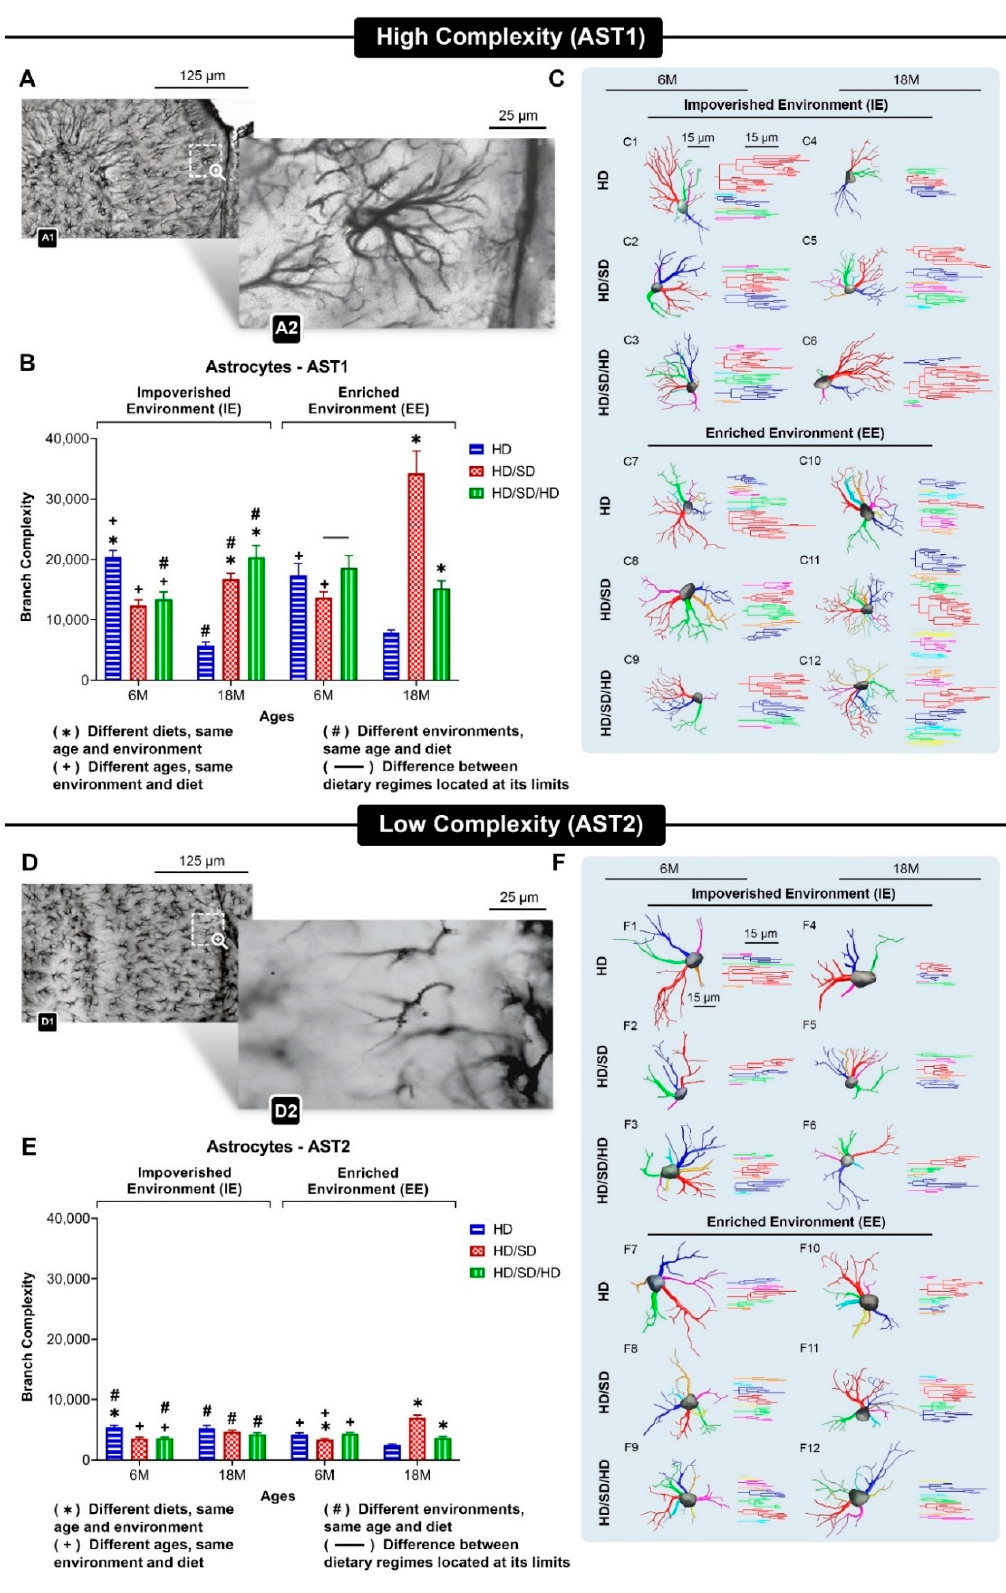
Figure 3. Three-dimensional reconstructions of astrocyte phenotypes (AST1 and AST2), under influence of different diet regimens (HD, HD/SD, and HD/SD/HD), environments (impoverished-IE vs. enriched-EE) and age (6M vs. 18M old). ( A , D ): Low (A1 and D1) and high (A2 and D2) power